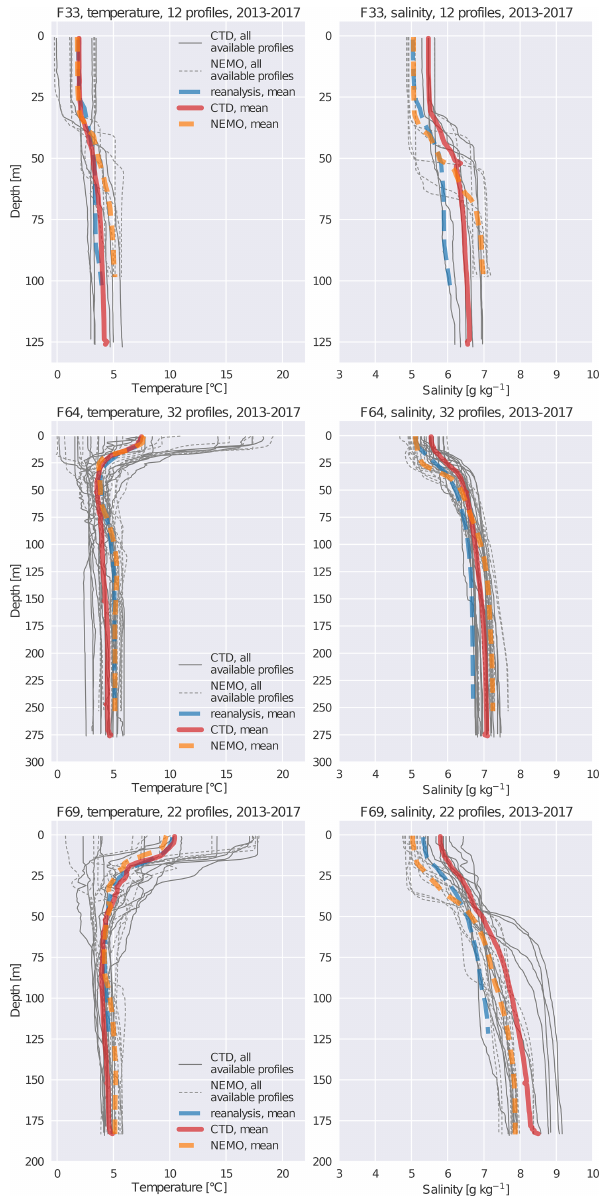
Figure 3. Temperature and salinity profiles from three monitoring stations 2013–2017. All available measurement profiles and corre- sponding modelled profiles are shown, along with their means. In addition, the mean of the profiles taken from the reanalysis product used as a boundary condition for the model is shown. Please note that the number of profiles varies from station to